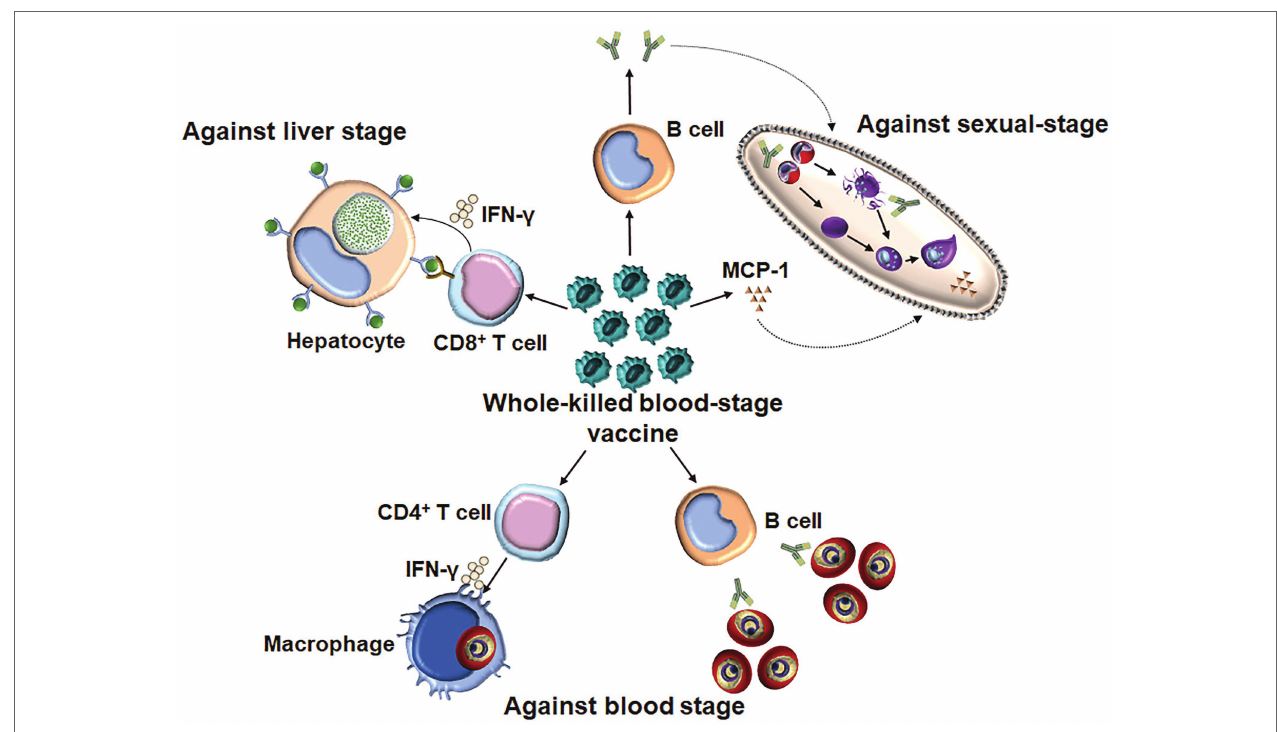
FIGURE 2 | The underlying mechanism of WKV against all three stages. WKV (an inactivate vaccine) could not only efficiently induce a protection against a blood- stage challenge but also confer the cross-stage protection against both liver stage and sexual-stage. The protective immunity against blood stage is dependent on both parasite-specific antibody and CD4 + T cells, which might enhance the capacity of macrophages to kill the intracellular parasite through the secretion of IFN- γ . WKV could also provide cross-protection against liver stage through priming parasite-specific CD8 + T cells, although the target antigen of which is still needed to be defined. In contrast, the protective immunity induced by WKV against sexual-stage is largely dependent on parasite-specific antibody and MCP-1, the non- specific effect of latter might explain the species-transcending protection against